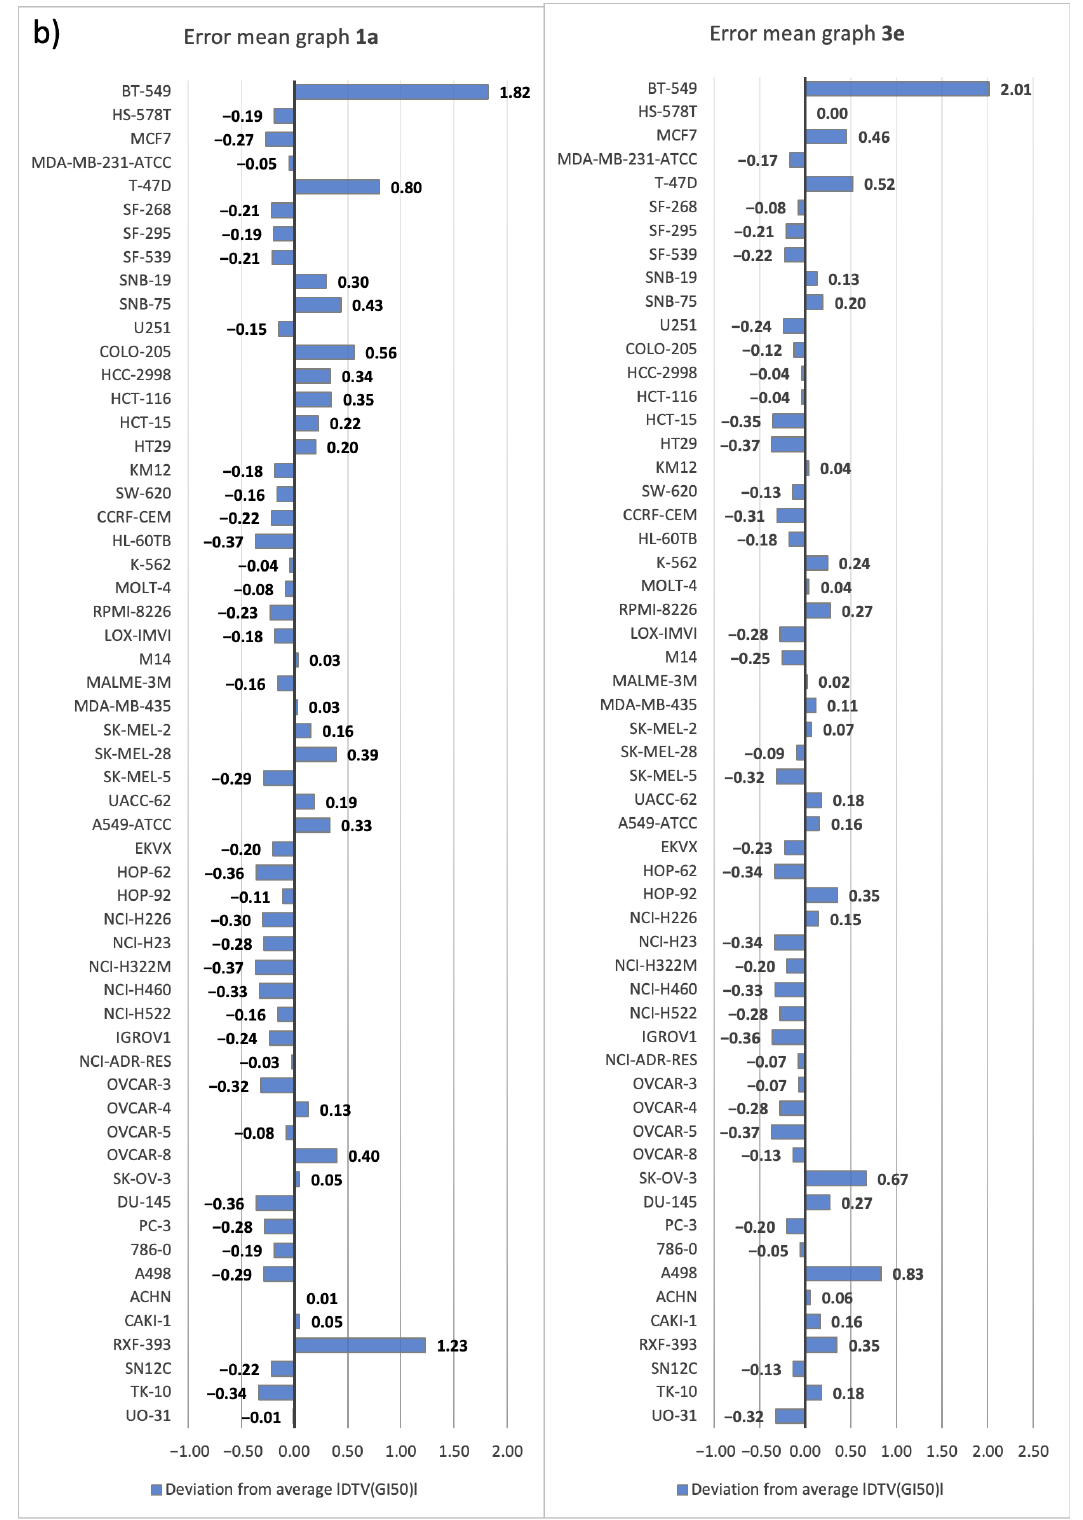
Figure 9. ( a ) Comparison between AAP-predicted GI 50 values and the corresponding experimental GI 50 values measured by NCI for the two selected compounds, 1a and 3e (inside each bar, the corresponding GI 50 value is indicated). ( b ) Mean error graphs for the two selected compounds, 1a and 3e